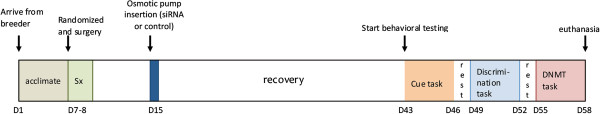
Timeline. Study timeline. Legends: D: day; DNMT: delayed non-matching-to-sample; Sx: sham or ischemia surgery.